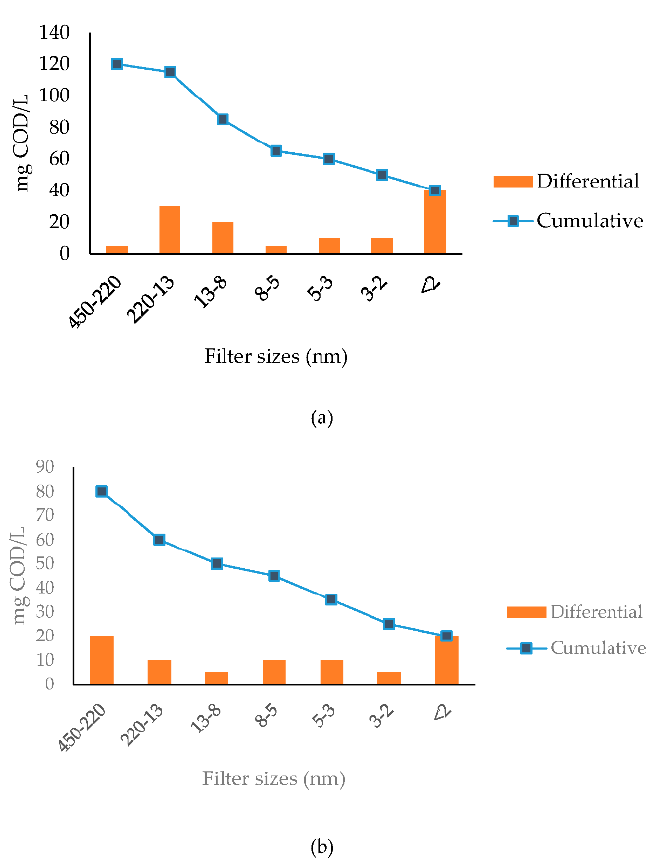
Figure 1. Related incremental and cumulative size distribution of soluble COD for ( a ) domestic sewage influent; ( b ) biological treatment effluent [29].